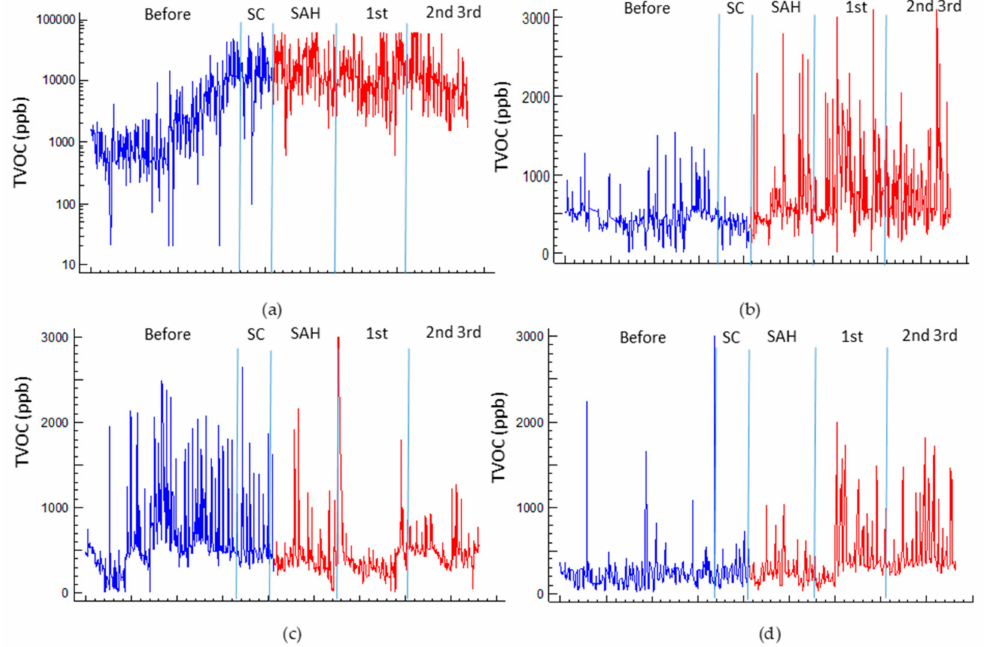
Figure 15. TVOC concentration temporal profiles (ppb) for previous operation (blue) and pandemic declaration-time (red) for Cases ( a ) 1 ( y -axis logarithmic), ( b ) 2, ( c ) 3, and ( d )